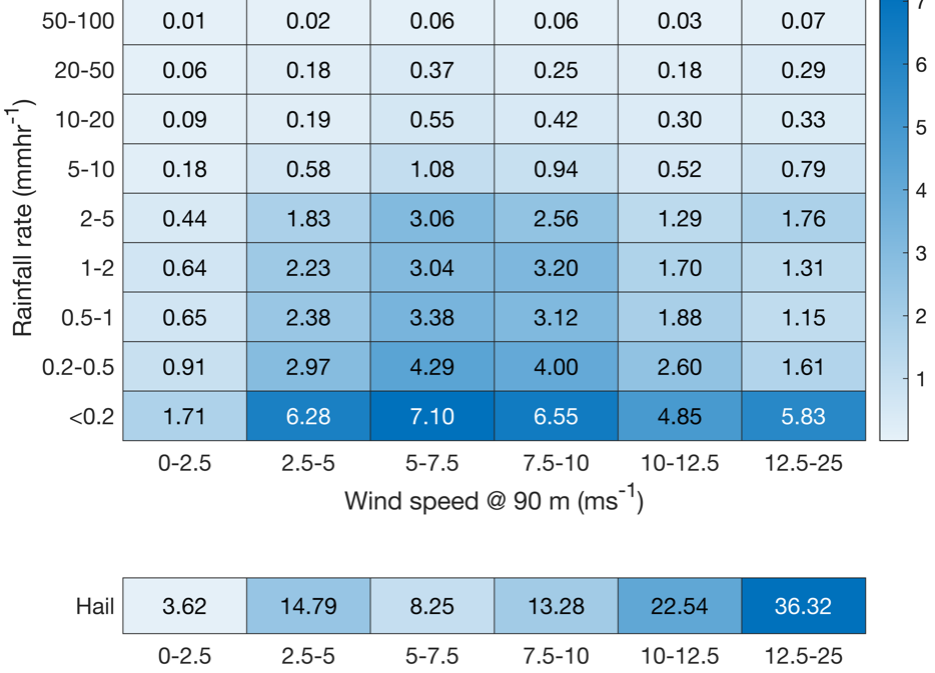
Figure 10. Heatmaps of the joint probabilities (in %, colorbar and also numeric values shown in each cell) of RR (rain only) and wind speeds at the US SGP site. The joint probabilities are computed for periods with precipitation and thus the sum of all cells is 99.8% since 0.2% of wind speeds are above 25 ms − 1 . Data for periods with hail (WC = 88 or 89) are processed separately and are shown in the lower panel. The values for hail sum to 98.8% because a few hail events are associated with wind speeds at 90 m in excess of 25 ms − 1 .